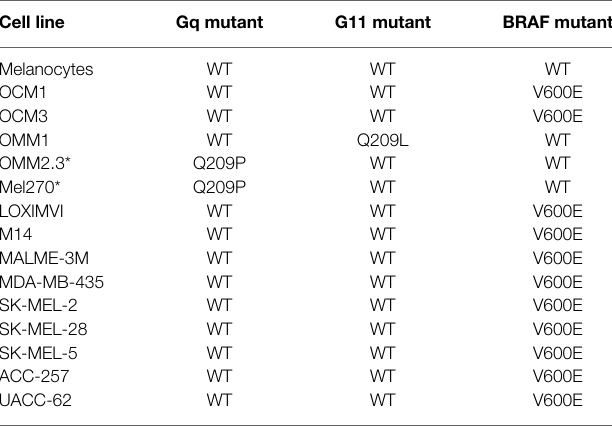
*Indicates cell lines from same patient. The cell lines used in this study are listed, along with their mutation status for GNAQ Q209P (Gq), GNA11 Q209L (G11), and BRAF V600E (BRAF). WT, wild